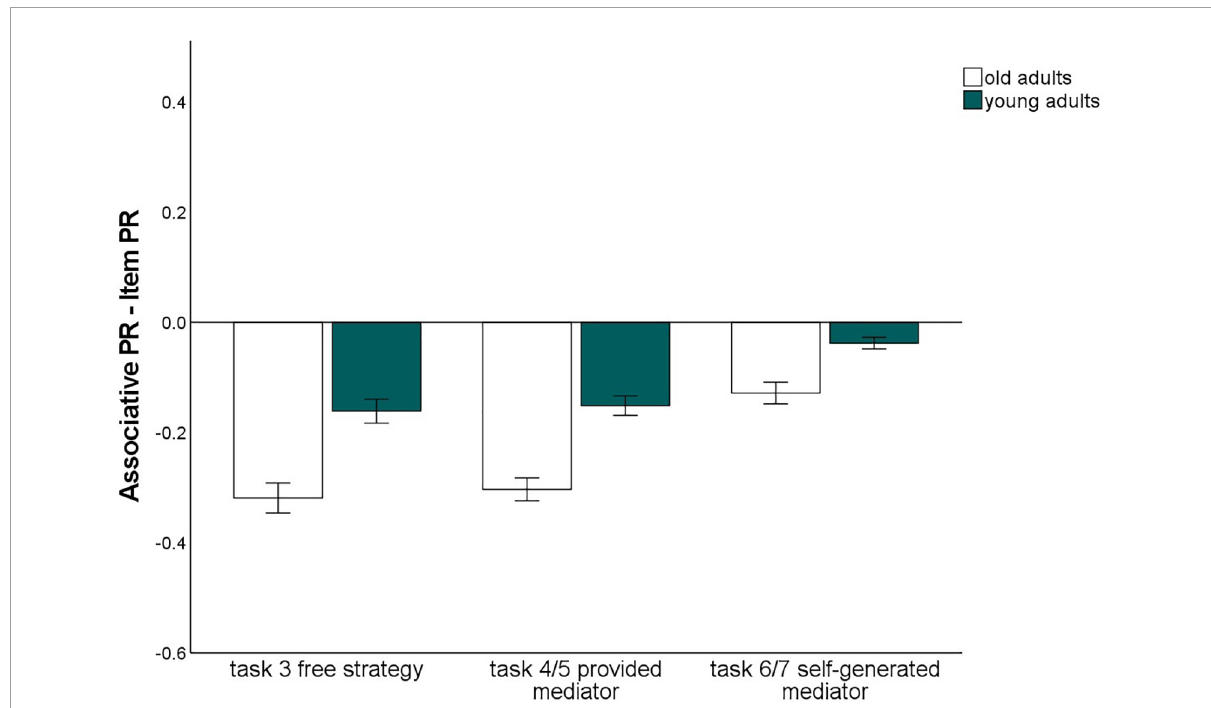
FIGURE5 Associative recognition PR, relative to item recognition PR, averaged over material types within each level of guidance. Error bars represent the standard of the error